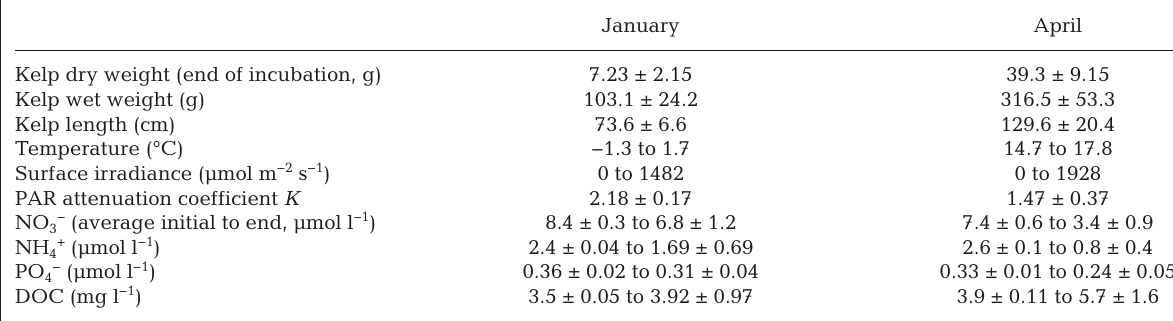
Table 1. Kelp and water parameters in the incubation containers. Data are mean ± SE (where